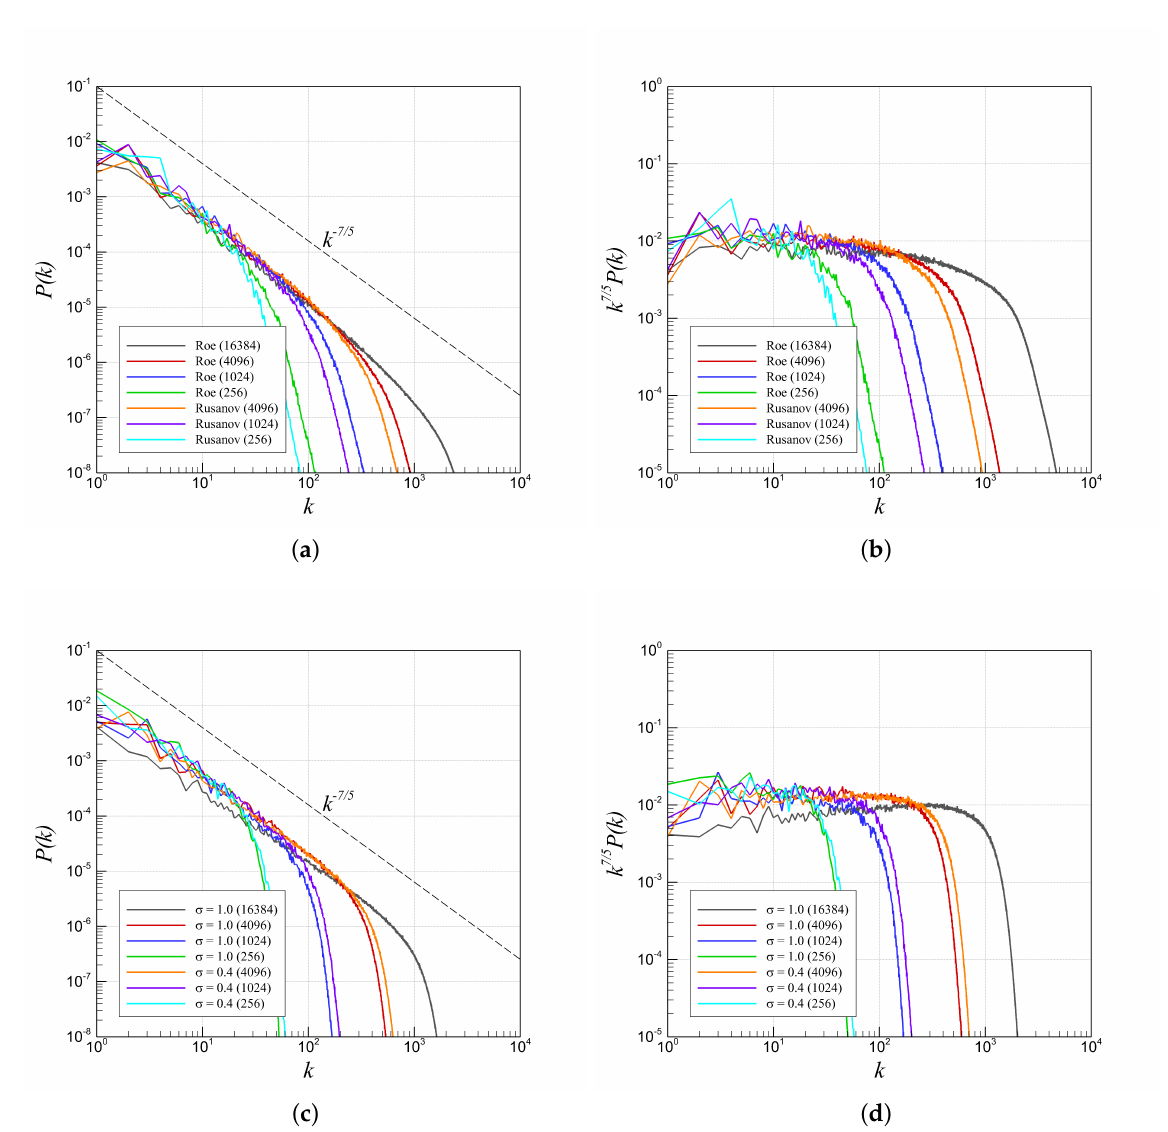
Figure 11. Comparison of ILES (ILES-Roe and ILES-Rusanov) models and CS+RF ( σ = 1.0 and σ = 0.4) models for the RTI problem with multi-mode perturbation showing the power density spectra and compensated power density spectra at different resolutions; ( a ) power density spectra using ILES solvers; ( b ) compensated power density spectra using ILES solvers; ( c ) power density spectra using CS+RF solvers; ( d ) compensated power density spectra using CS+RF